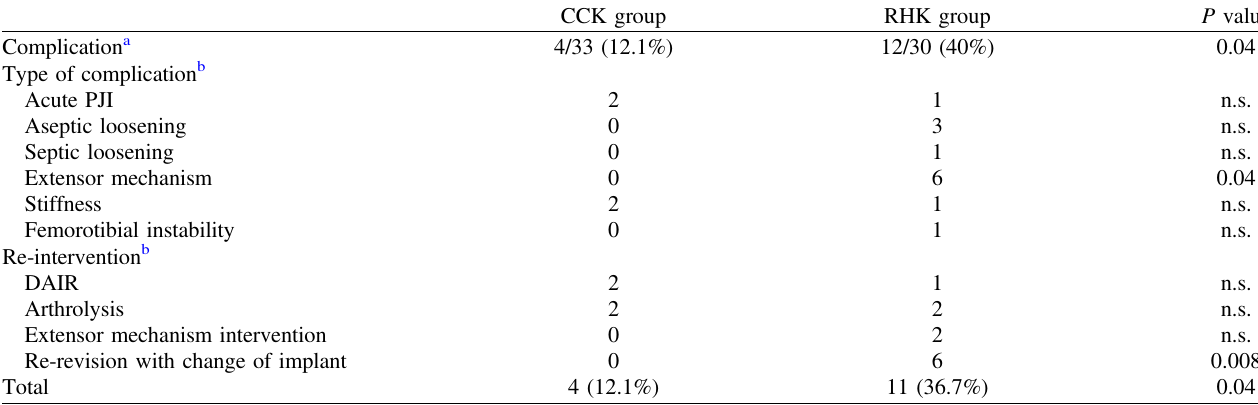
Table 3. Complications related to the revision prosthesis at two years.